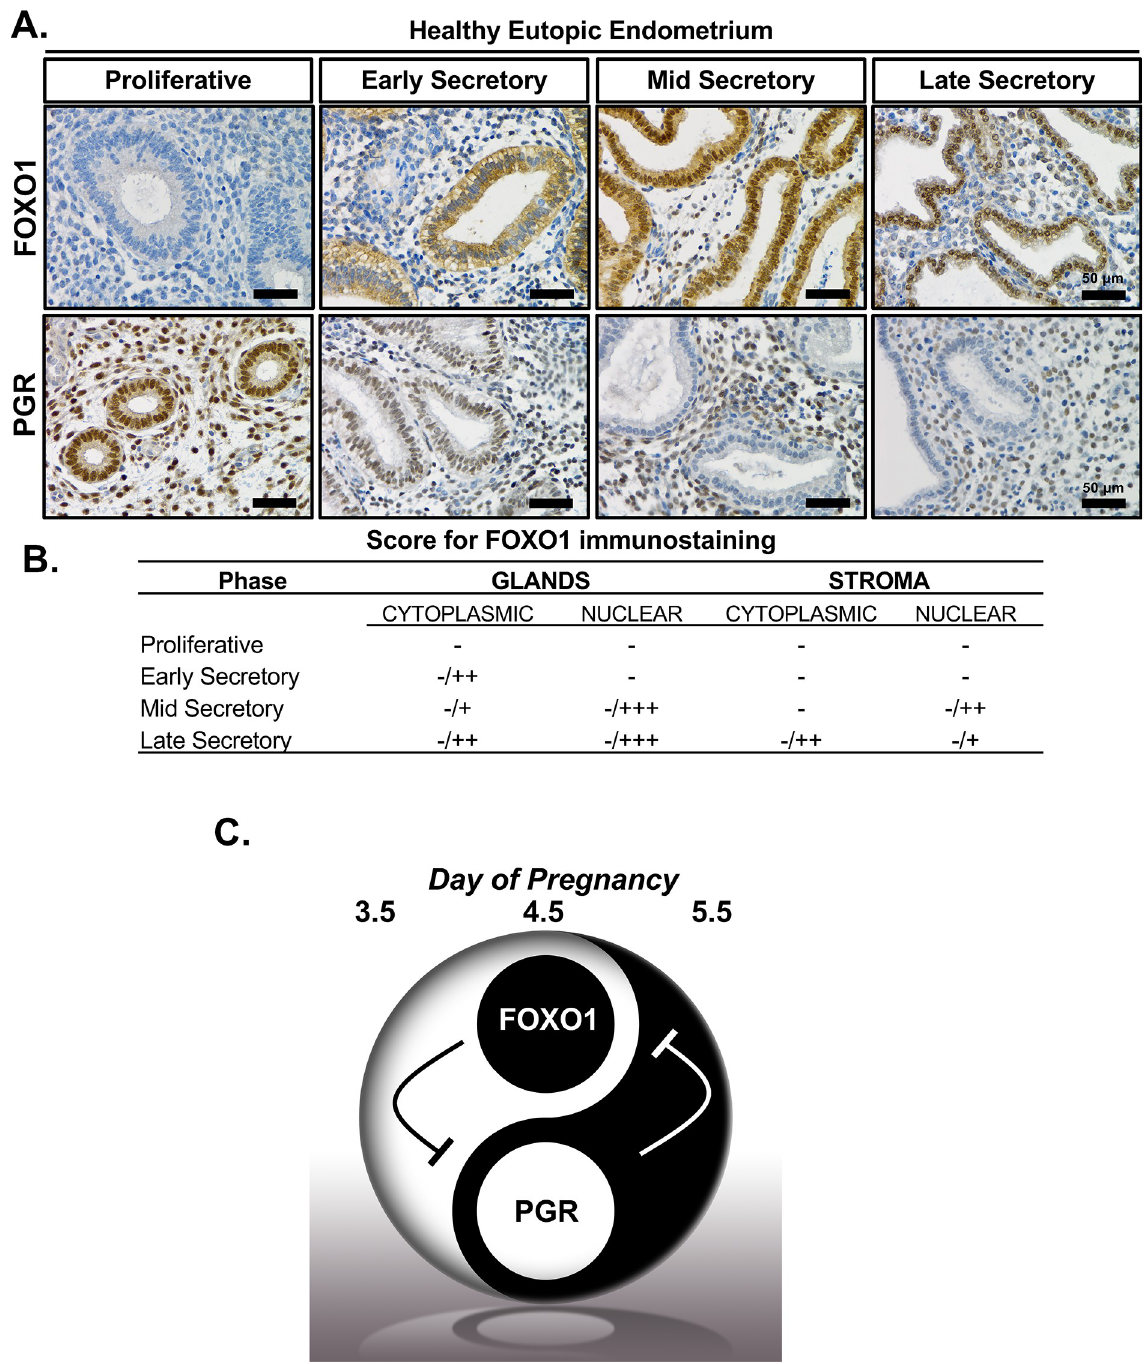
Fig 7. Conserved FOXO1 and PGR balance in endometrial receptivity in human. (A) Immunohistochemical staining for FOXO1 and PGR on endometrial sections from the functional layer of the endometrium in the proliferative, early secretory, mid-secretory, and late secretory phase of the menstrual cycle ( n = 5). Scale bar, 50 μ m. (B) Score for the compartmental and sub-cellular FOXO1 immunostaining across the menstrual cycle. Intensity indicated as follows: -, negative; +, weak; ++ moderate; +++, high. The slash is meant to show range given the variation in the samples ( n = 5) (C) Proposed model for the temporal downregulation of Pgr in the LE of the endometrium by FOXO1 across the WOR.